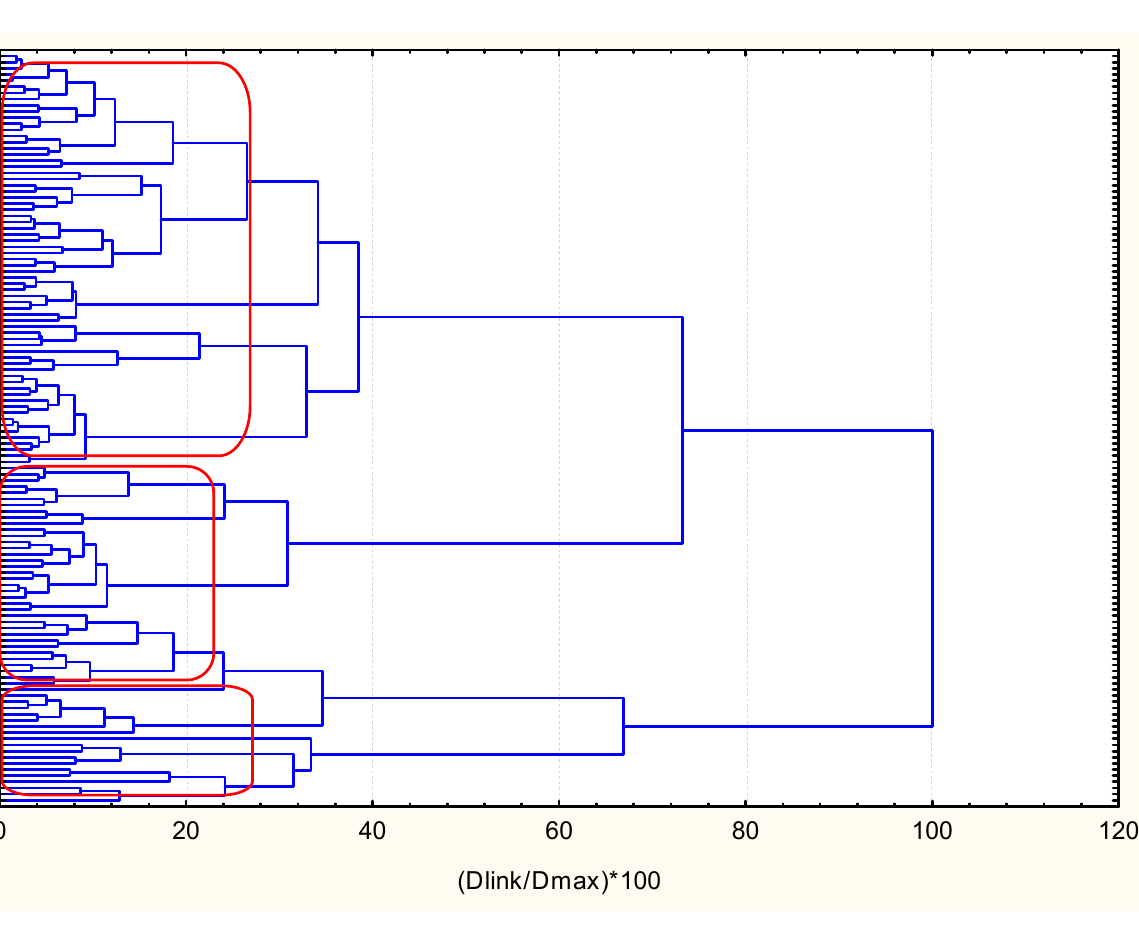
Figure 2. Hierarchical dendrogram for linkage of 124 patients.